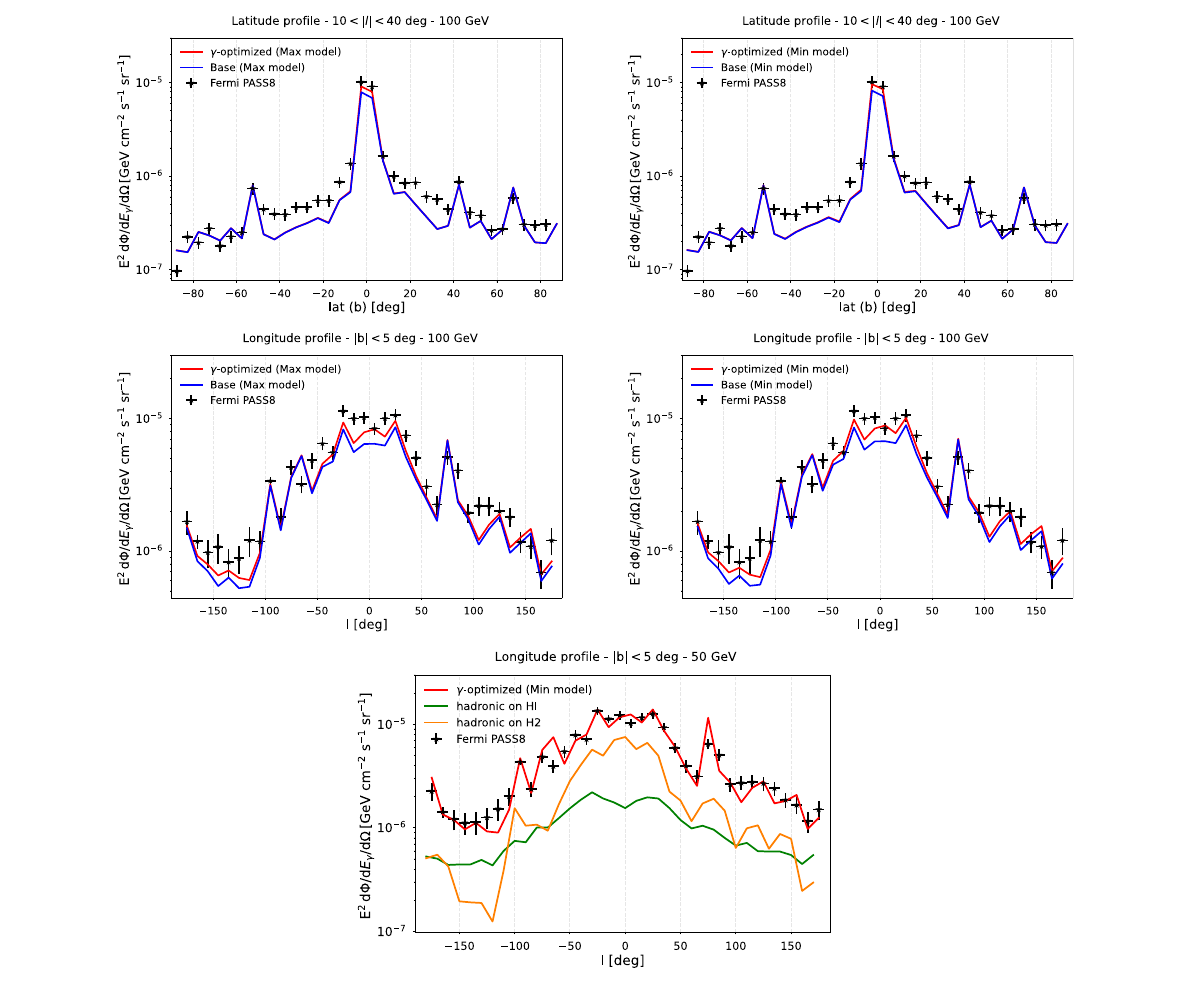
FIGURE 3 Upper panels show the latitude profiles for the total γ -ray emission (for longitudes of 10 ° < | l | < 40 ° ) at 100 GeV predicted by the Base and γ - optimized models for the Max (left) and Min (right) configurations. Likewise, middle panels show longitude profiles at 100 GeV predicted by the Base and γ - optimized models for the Max (left) and Min (right) configurations. The bottom panel reports the longitude γ -ray profile at 50 GeV predicted by the γ - optimized model (Min configuration), showing the emission that comes from the hadronic emission generated by HI (atomic) and H2 (molecular) gas. Fermi-LAT PASS8 data are added for comparison in every case.